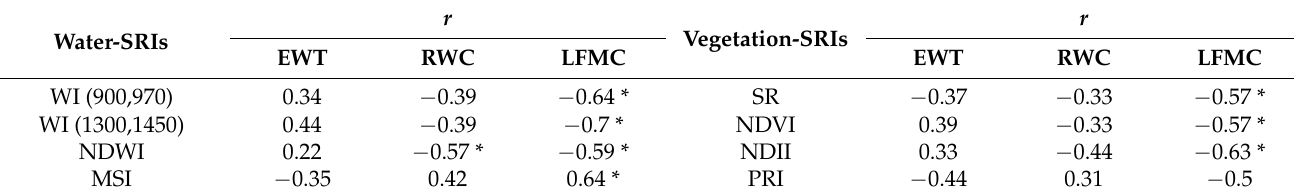
Table 2. Coefficients of correlation ( r ) between existing spectral reflectance indices and leaf water content. r Water-SRIs